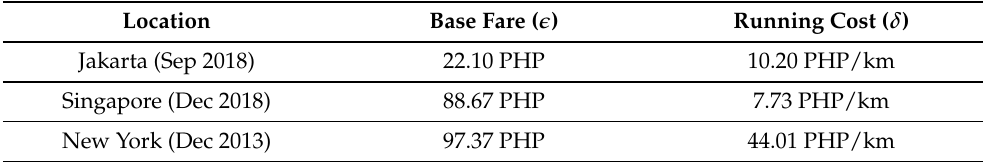
Table 2. Fare Table